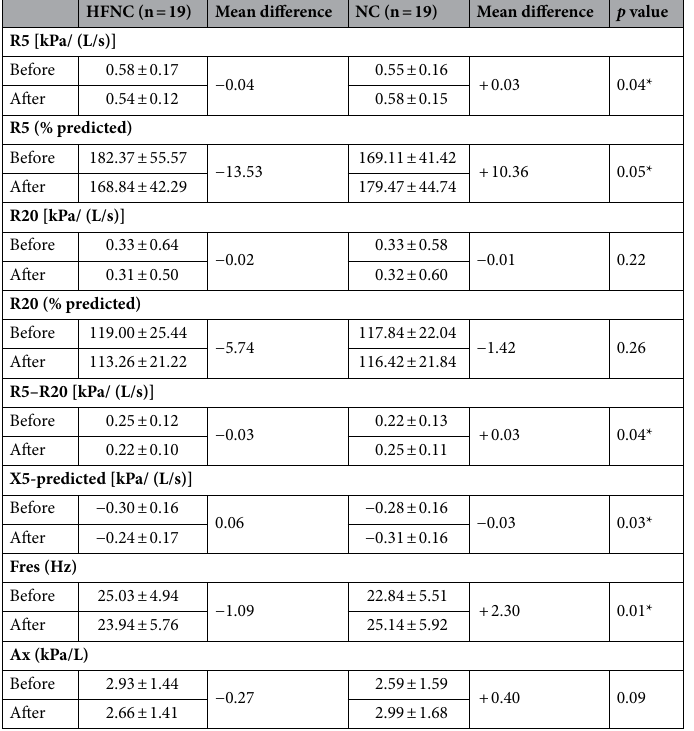
Table 2. The effect of HFNC and NC intervention on respiratory impedance evaluated by IOS. Analysis of Covariance (ANCOVA) test, p < 0.05. HFNC high flow nasal cannula, NC nasal cannula, IOS impulse oscillometry, R5 resistance at 5 Hz, R20 resistance at 20 Hz, R5 − R20 difference between R5 and R20, X5 reactance at 5 Hz, Fres resonant frequency, Ax area under reactance curve between 5 Hz and resonant frequency. *Significance between high-flow nasal cannula and nasal cannula.